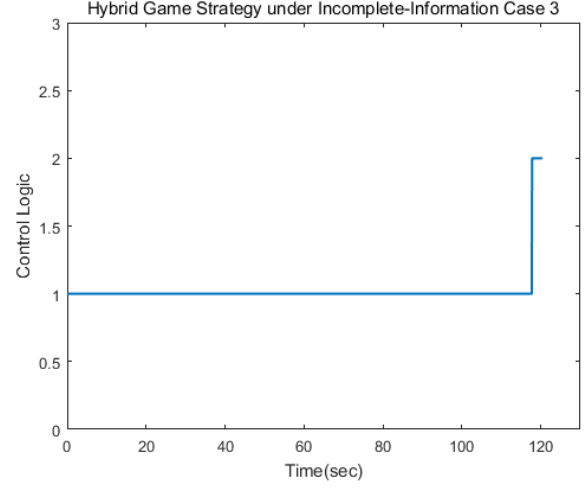
Figure 23. Control logic.